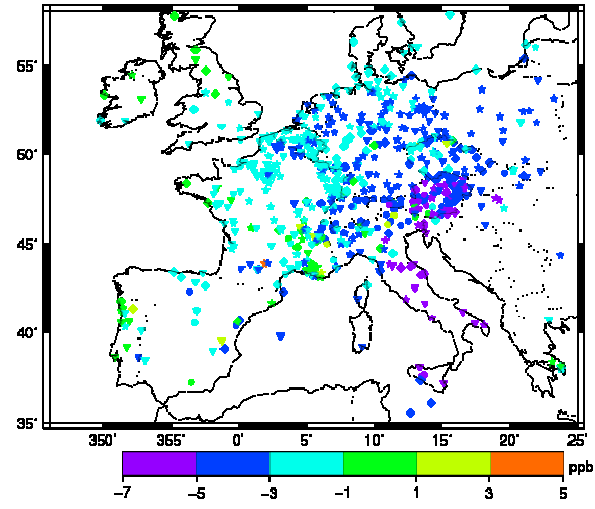
Figure 12. Difference RMSE_EnSRF minus RMSE_Ref calculated using two simulations: one with assimilation, called EnSRF and the second one without assimilation, called Ref (against measurements) at 9 a.m. calculated over the month July 2007, for each of 703 ground-based stations from the AIRBASE network. Different symbols were used for each class type: circles for the ALT stations, diamonds for the M, stars for the P and triangles for the R (see the four types of stations in Table 3). The color scale varies from violet representing relatively low values, to red representing relatively high values and min/max values from -7 ppb to 5 ppb.